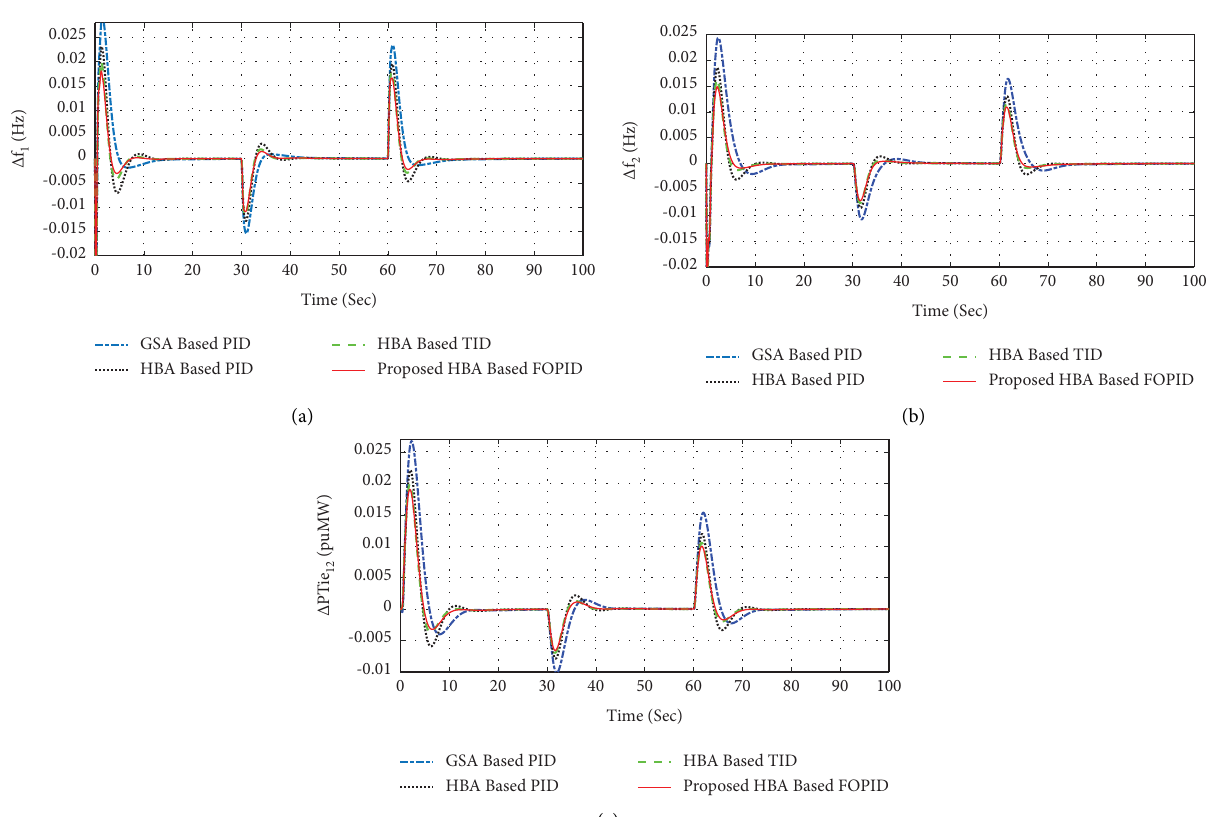
1 , (b) A 2 , and (c) P tie12